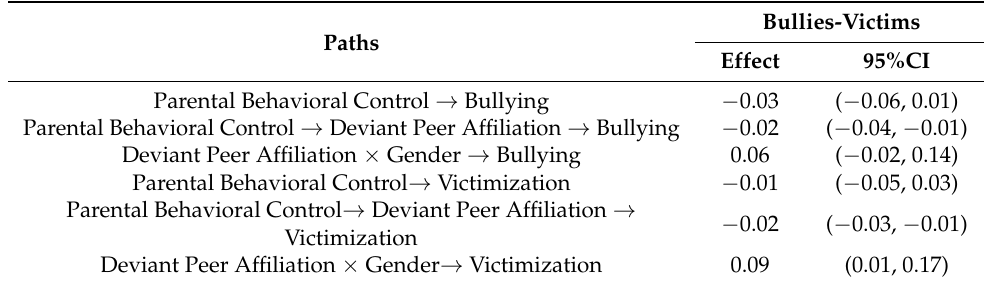
Table 5. Direct and indirect effects between parental behavioral control and bullying; victimization in the bullies-victims group ( n =